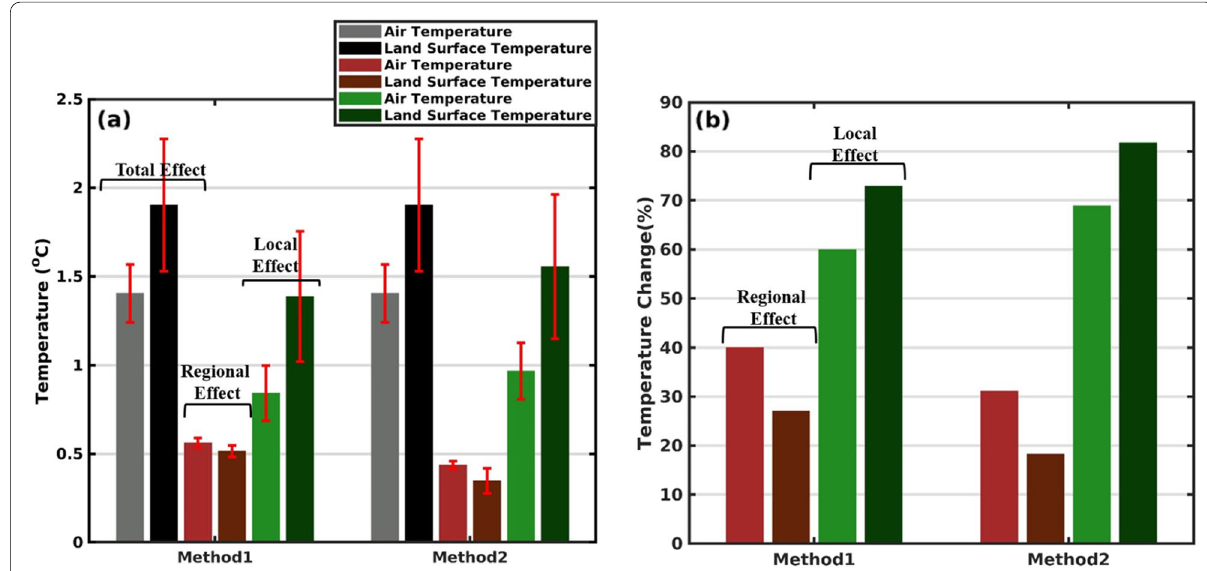
Fig. 6 Quantifying the temperature changes. ( a ) The difference in air temperature and surface temperature in degree Celcius ( b ) difference in temperature in terms of